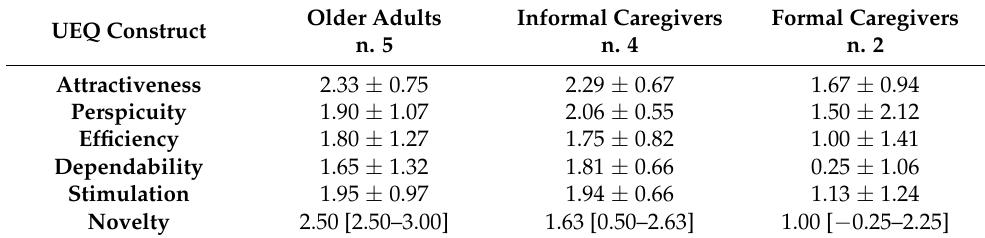
Table 11. UEQ scale